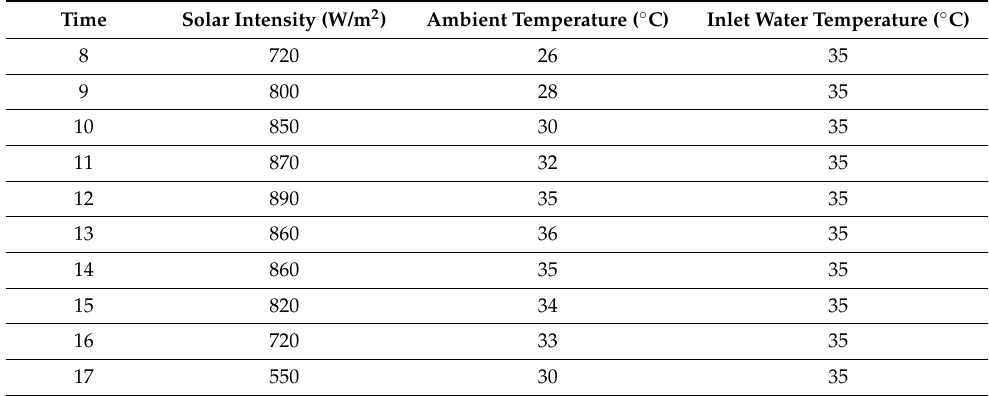
Table 3. Weather conditions of the PVT water collector [42].